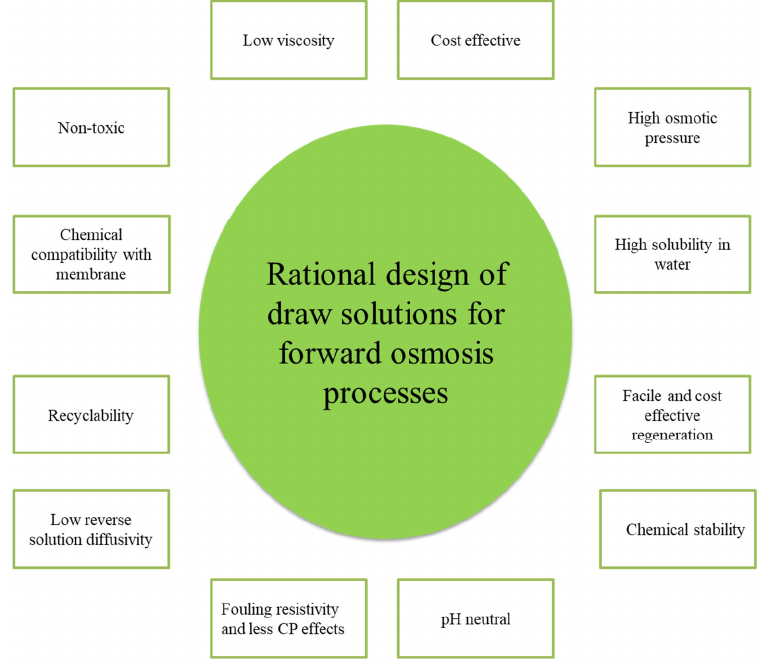
Figure 10. Rational design idea of draw solutions for FO processes.